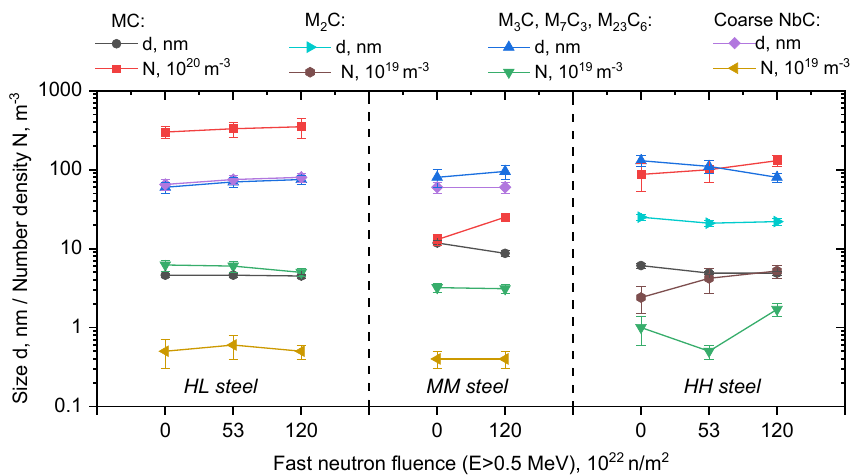
Figure 1. Parameters of initial carbide phases in the studied steels in the initial state and after irradiation at 400 °C up to (53–120) × 10 22 n/m 2.